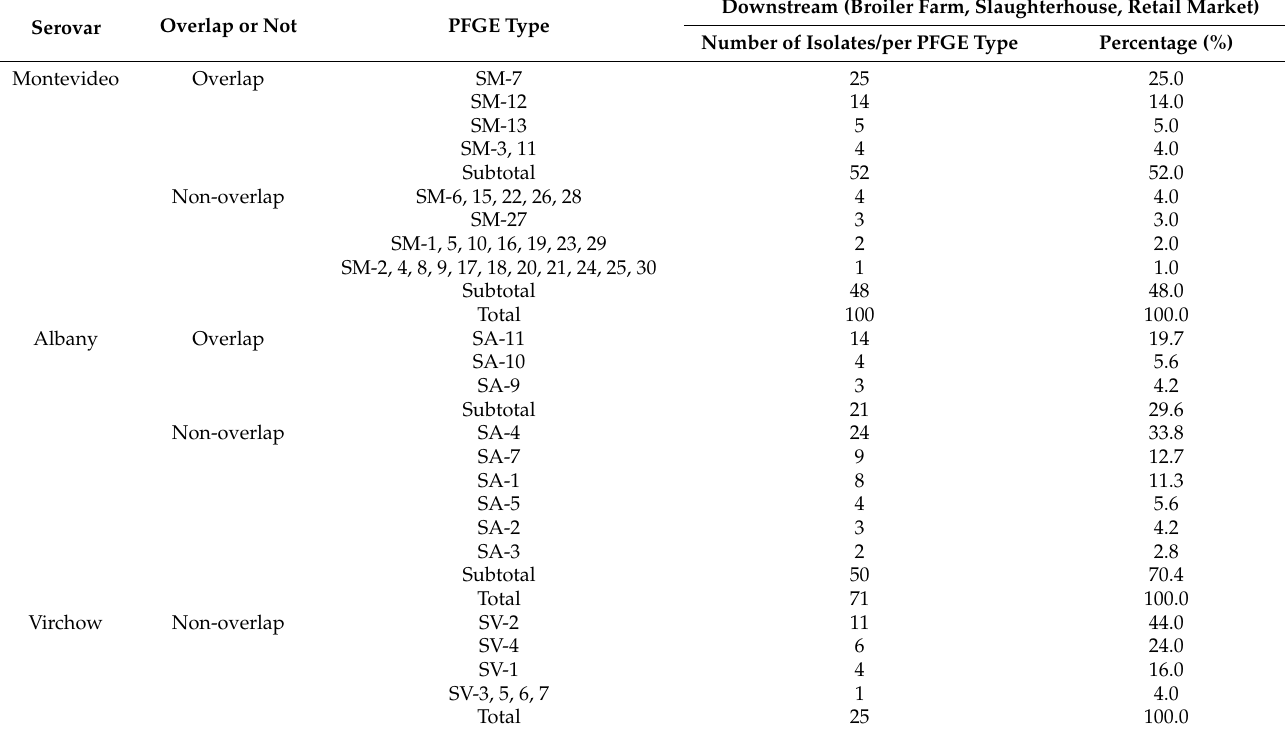
Table 6. The prevalence of Salmonella isolates from downstream of the hatchery stage along the integrated broiler chicken operation, with overlapped PFGE types with the hatchery stage